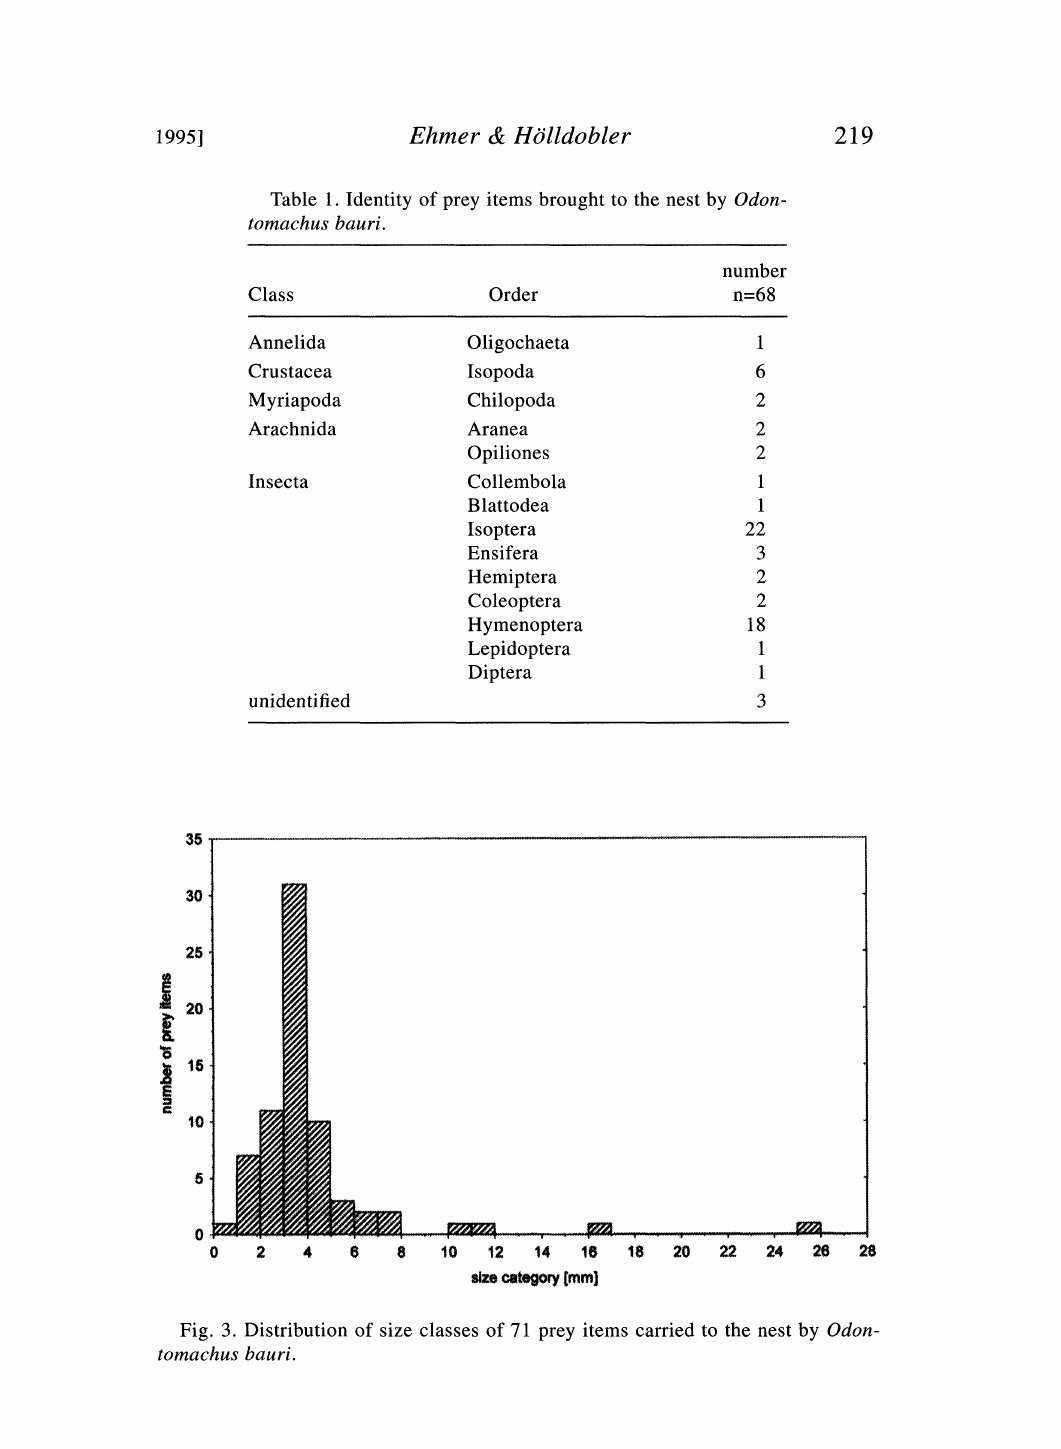
Table 1. Identity of prey items brought to the nest by Odon- tomachus bauri.